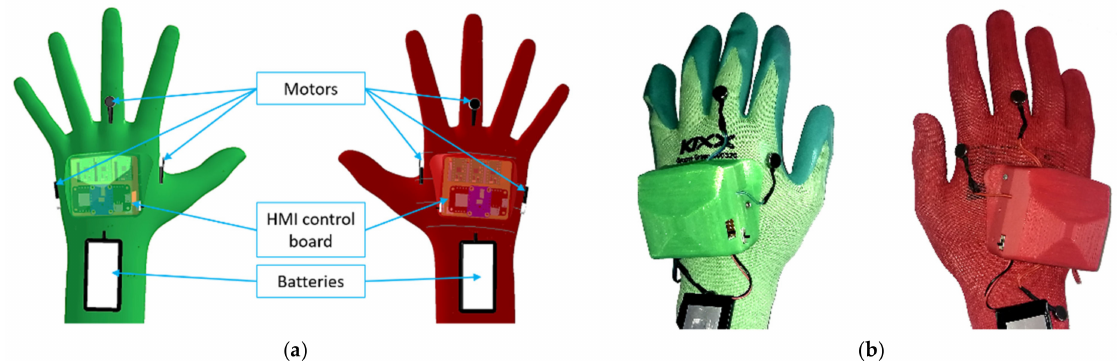
Figure 7. Prototype of HMI: ( a ) 3D model of HMI prototype, HMI cover is set as translucent in order to visualise the internal placement of the components; ( b ) implemented